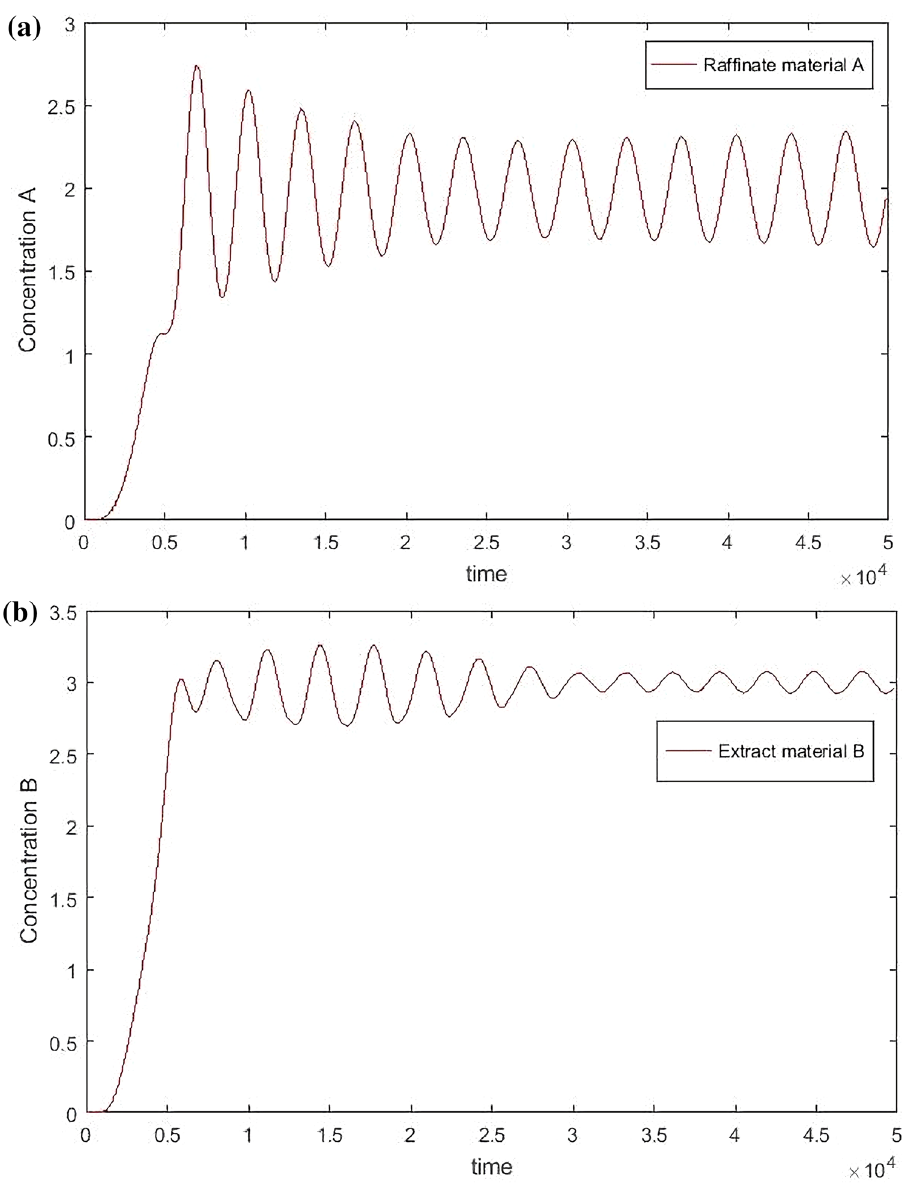
Figure 11. Hierarchical Fuzzy Rule Control for concentration, desired B = 3, desired A =